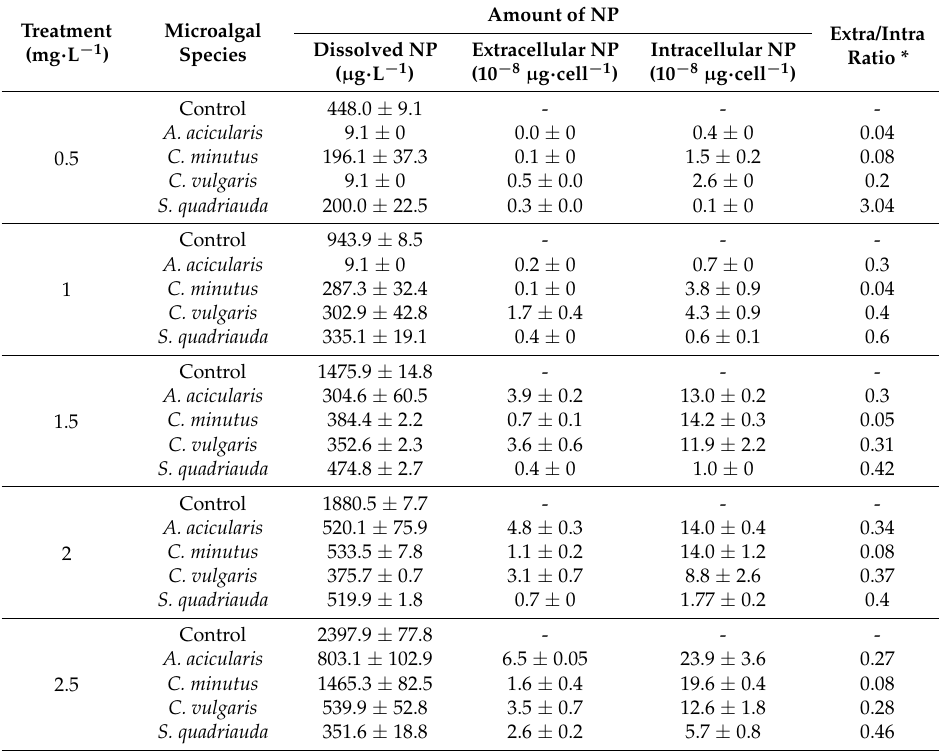
Table 3. Dissolved, intracellular and extracellular NP contents of four freshwater microalgae under different treatments at the end of 120 h. Mean and standard deviation of three replicates are